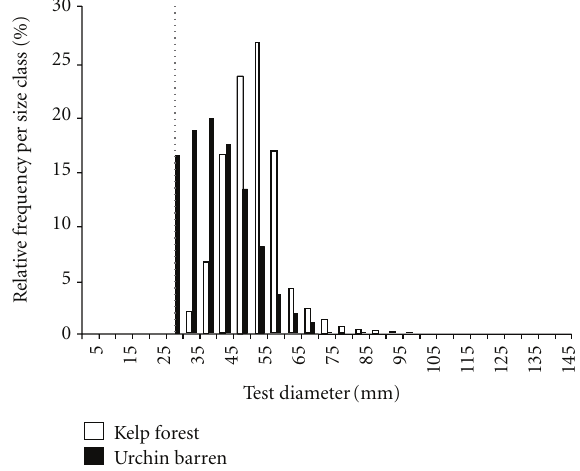
Figure 2: Relative frequency distributions of sea urchins ( Strongylo- centrotus polyacanthus ) collected in remnant kelp forest and urchin barren communities in the central and western Aleutian Islands. Relative frequency percentages are determined using counts from sea urchins in kelp forests ( n = 308) and urchin barrens ( n = 4569). The dotted line indicates the minimum size threshold for sea otter predation on urchins